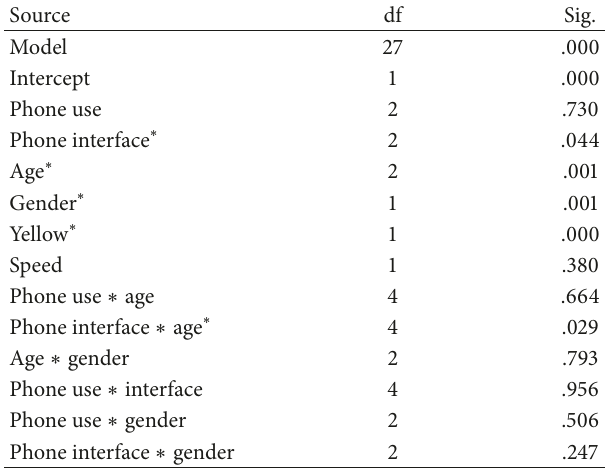
Table 3: Result of model and parameter estimation (‘Go’ sample), QIC =